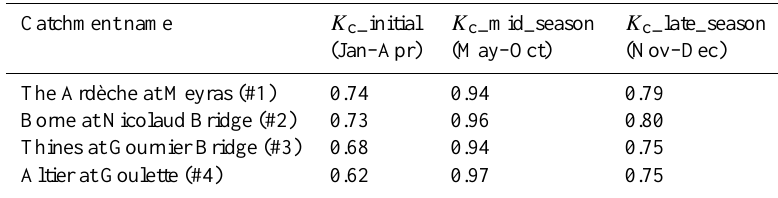
Table 2. Weighted average crop coefficient for each examined catchment per growing stage.